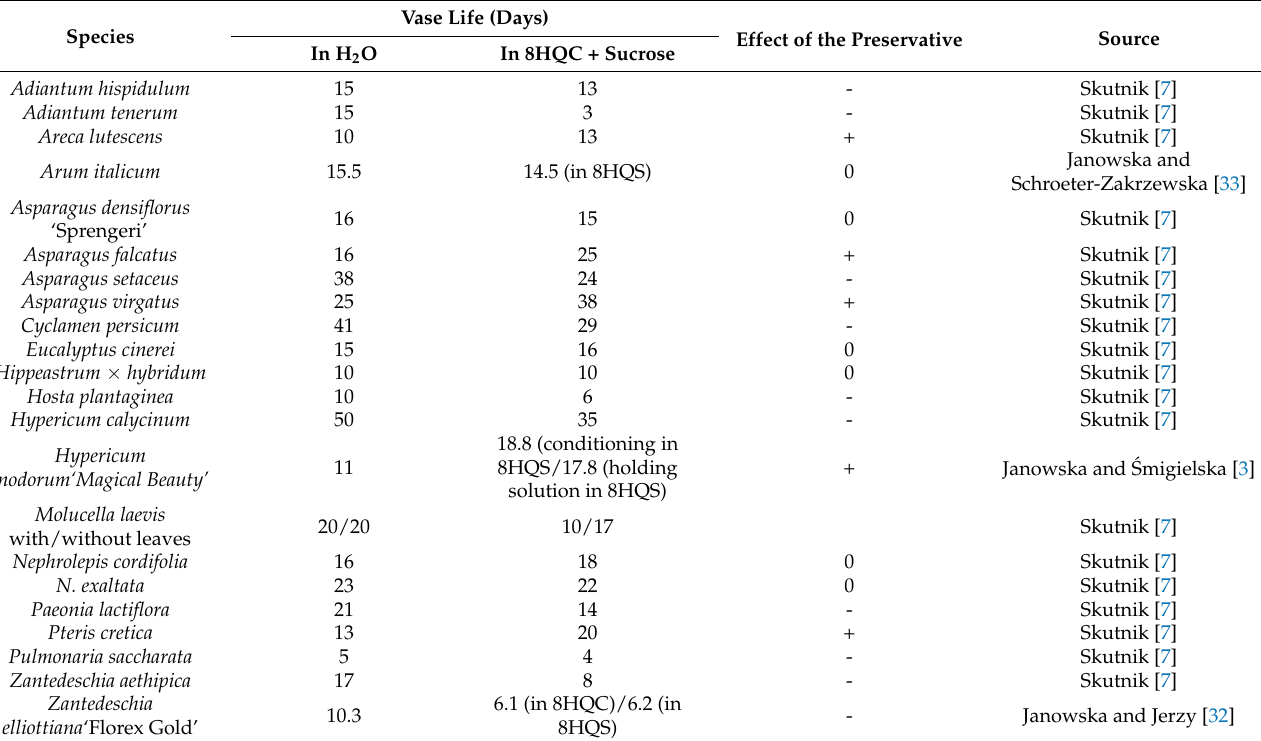
Table 1. Vase life of florists’ greens after the application of 8HQC + 2%